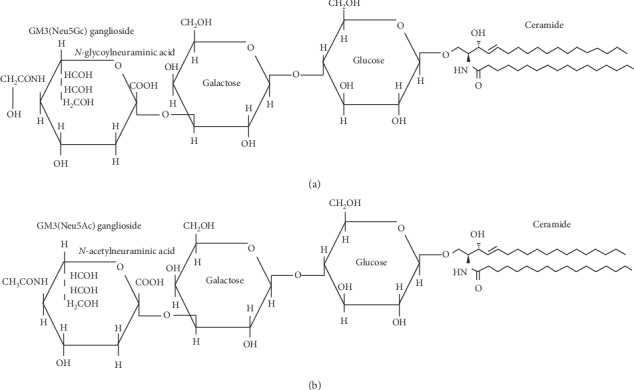
Chemical structures of NeuGcGM3 and NeuAcGM3 [1].